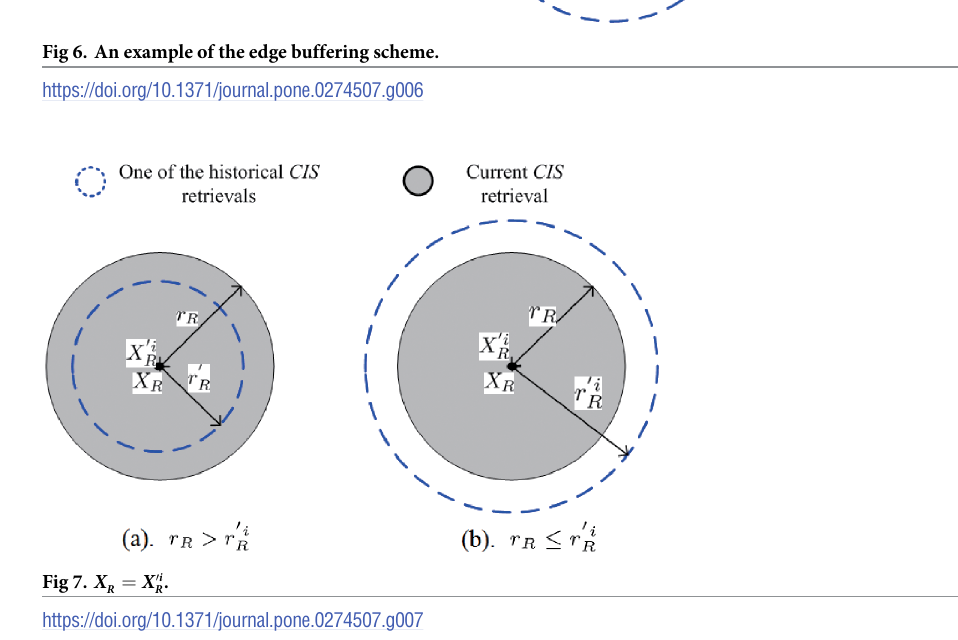
; r Þ ; Y ð X 0 i ; r 0 i ÞÞ ¼ NULL , ( b ). AA ð Y ð X R R R R ; r Þ . R R